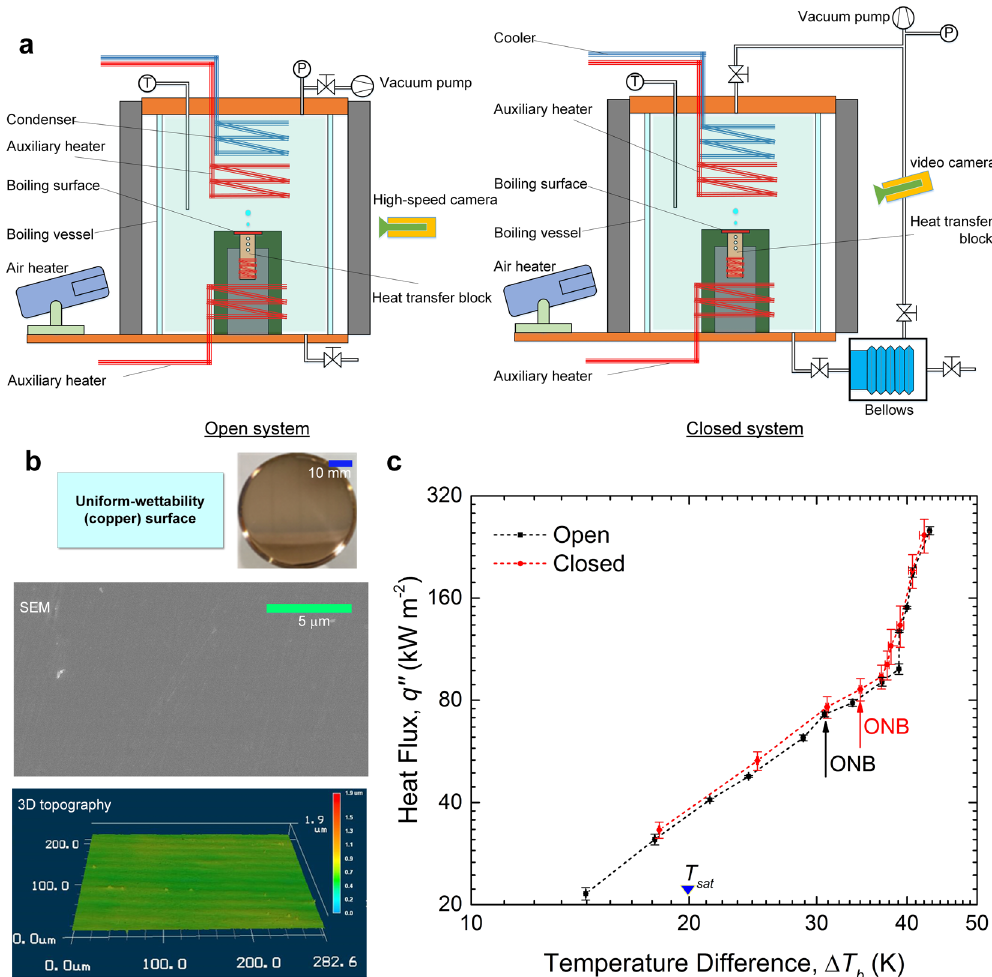
Figure 1. Pool boiling experiments using open and closed setups. ( a ) Boiling experimental apparatuses of the open and closed systems. Instead of boiling deaeration, more thorough vacuum degasification was employed in the closed system. The content of dissolved air in subcooled water ( T bulk = 80 °C) decreased from c g ≈ 5.53 ppm in the open vessel to c g < 0.7 ppm in the closed system that can be hermetically sealed off from the atmosphere, thanks to a pressure-stabilizing rubber bellows. Heat was incrementally applied to the heat transfer block to generate boiling on its upward-facing surface of 30 mm in diameter. The surface temperature and heat flux was calculated by a heat conduction model based on steady-state measurements of the three thermocouples embedded along the length of the heat transfer block. ( b ) A homogeneous boiling surface with uniform wettability. The plain copper surface with a contact angle ≈ 80°, polished to a mirror finish, was largely free of surface defects as shown by the scanning electron microscope (SEM) image. The surface morphology measurement by a 3D laser profilometer shows an average roughness of 0.03 µ m. (c) Plot of the boiling curves obtained for the homogeneous surface. The boiling incipience superheat ( Δ T sat = T w -T sat ) rose slightly from Δ T sat = 12.8 K in the open system to Δ T sat = 15.2 K in the closed system. Error bars represent standard deviations of the least-square fittings. Despite the somewhat lower ONB in the open system, BHT varied little following the dissimilar degassing schemes in the present